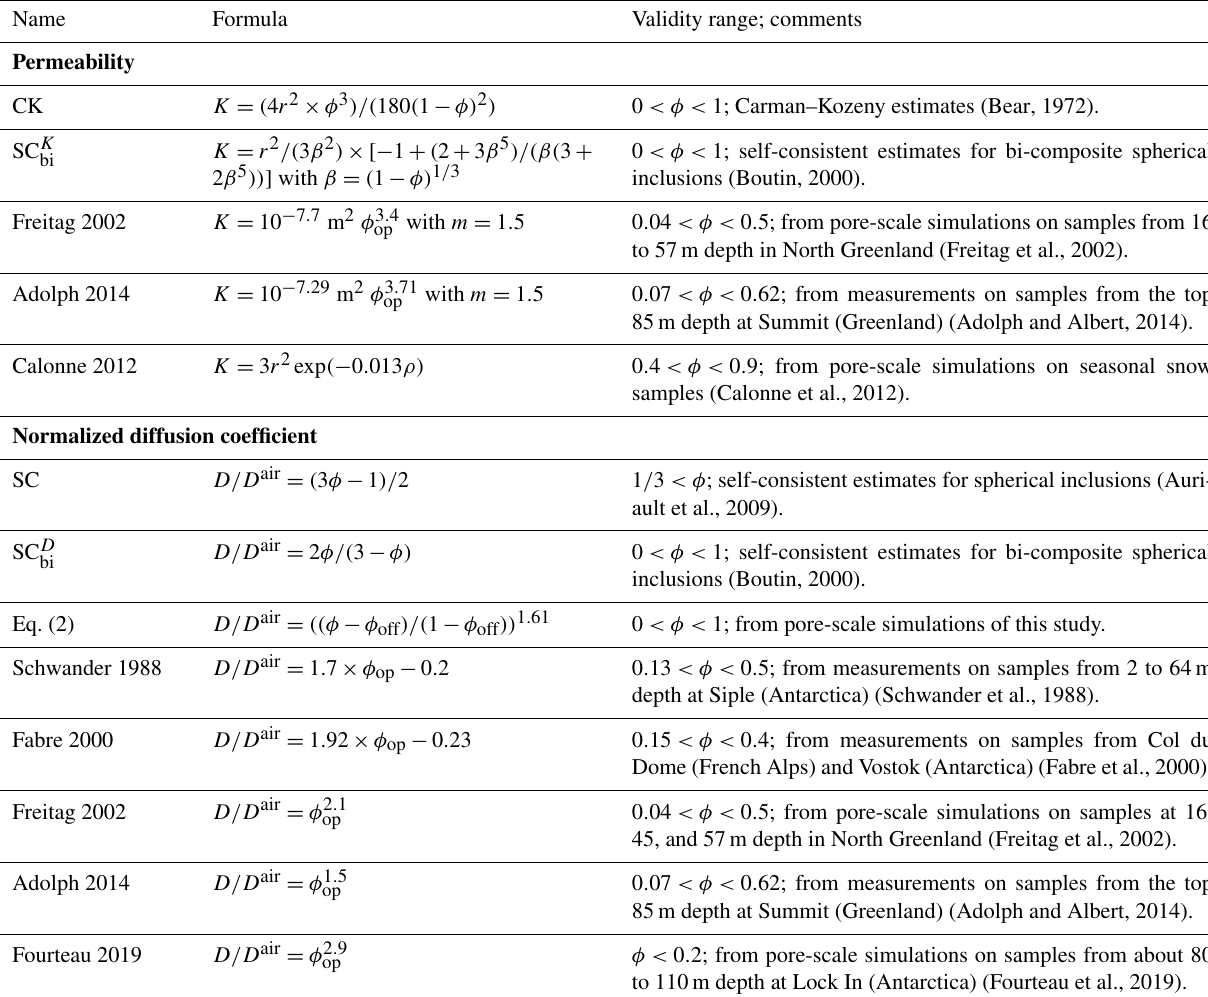
Table 1. Description of the analytical models and regressions of permeability and normalized diffusion coefficient for comparison with our